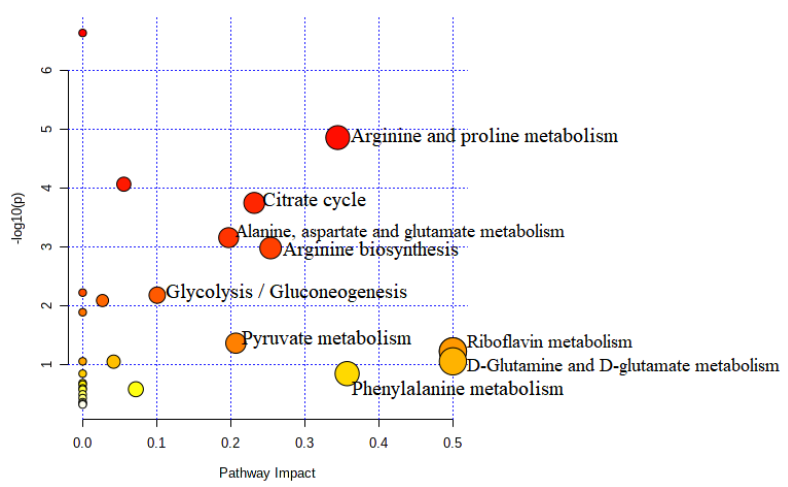
Figure 14. Summary of the pathway analysis of uninfected RBCs treated with CQ.